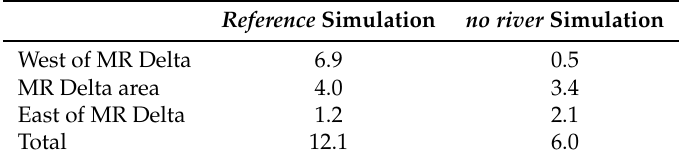
Table 2. Percentages of stranded oil elements for the May 20–27 simulations.